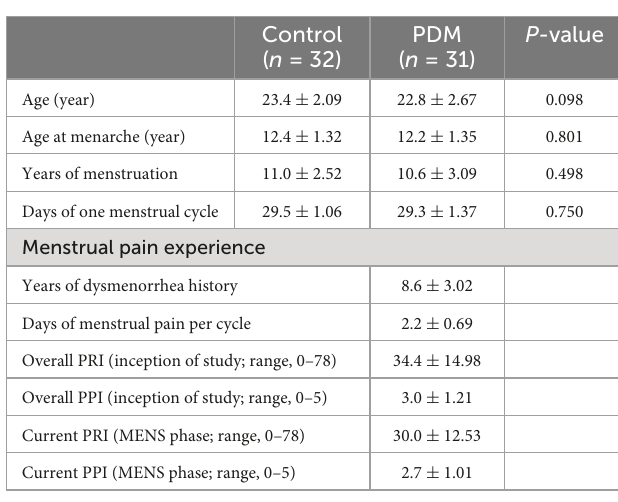
TABLE 1 Demographic data and baseline information of PDM and control